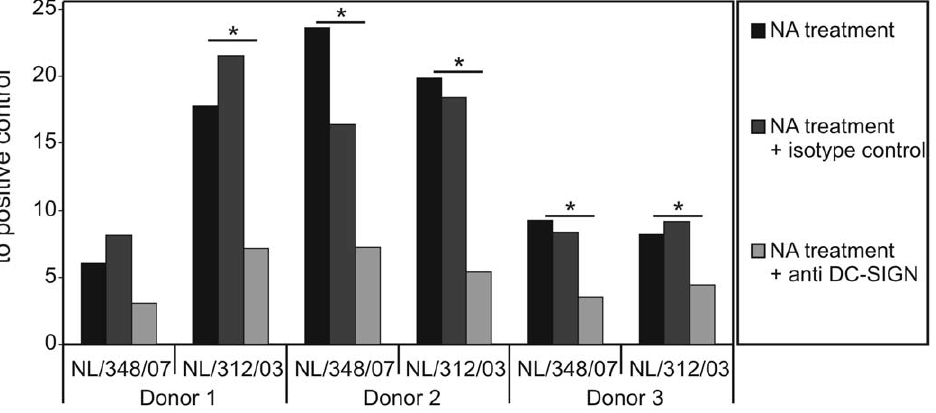
Figure 6. DC-SIGN expression on DC supports replication of influenza virus in absence of sialic acids. DC were treated with neuraminidase from vibrio cholerae for 30 minutes to remove sialic acids from the cell surface and incubated with or without antibodies to DC-SIGN or an isotype control antibody as indicated. These cells were subsequently inoculated with two A/H3N2 influenza viruses. The percentage of infected cells compared to the positive control (untreated cells, still possessing of sialic acid) was assessed as described